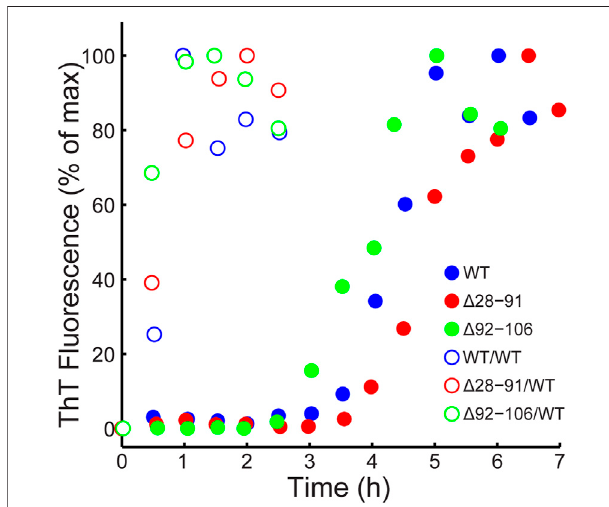
FIGURE 1 | Kinetics of amyloid formation monitored by thio fl avin T fl uorescence in the absence ( fi lled circles) and presence (open circles) of 2% (mole fraction) of WT huPrP23-144 fi brilseeds for WT (blue), Δ 28-91 (red) and Δ 92-106 (green) huPrP23-144.